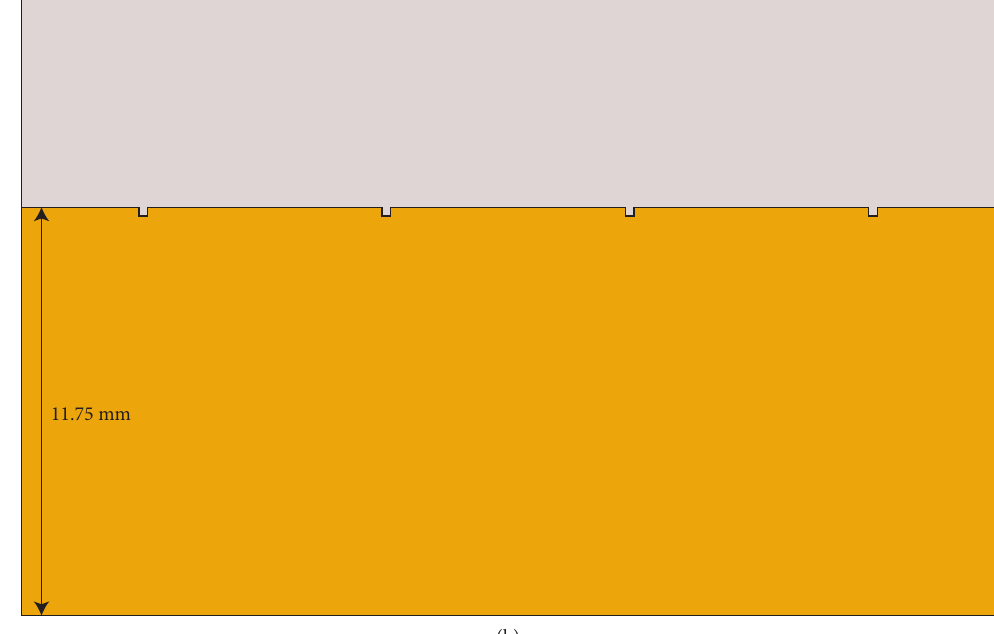
Figure 5: Design of the proposed 1 × 4 linear antenna array: (a) front view; (b) back view.